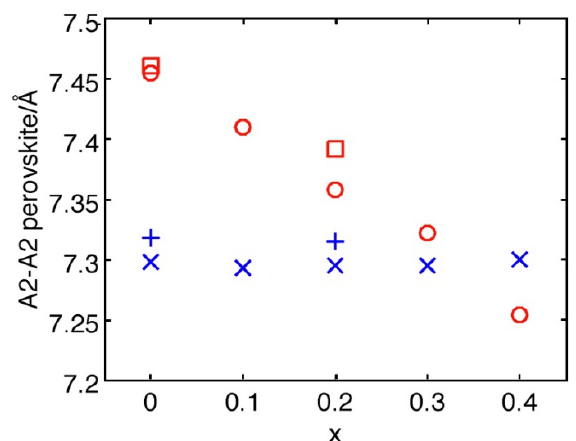
Figure 5. Size of the perovskite slab along the c -axis measured as A 2– A 2 interatomic distance versus Pr-content, x , for N 2 -annealed (XRD data—red circles, NPD data red squares) and air-annealed